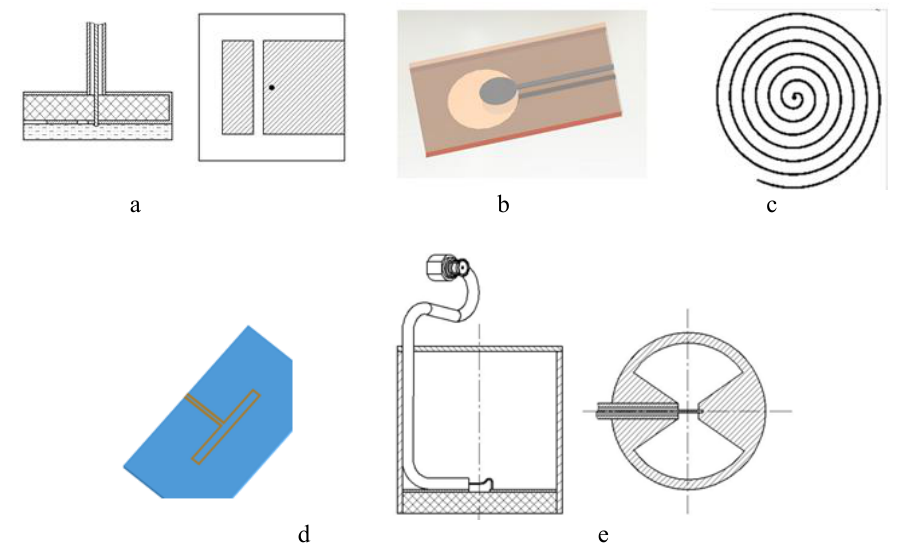
Fig. 1. Main types of medical printed antennas: a - patch antenna; b - elliptical antenna; c - spiral antenna; d - dipole printed antenna; e – slot